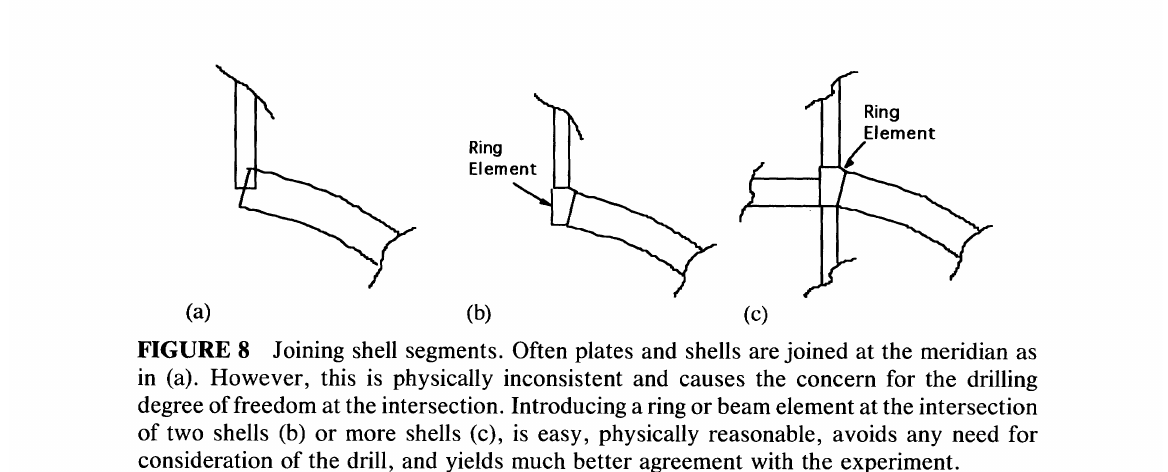
FIGURE 8 Joining shell segments. Often plates and shells are joined at the meridian as in (a). However, this is physically inconsistent and causes the concern for the drilling degree of freedom at the intersection. Introducing a ring or beam element at the intersection of two shells (b) or more shells (c), is easy, physically reasonable, avoids any need for consideration of the drill, and yields much better agreement with the